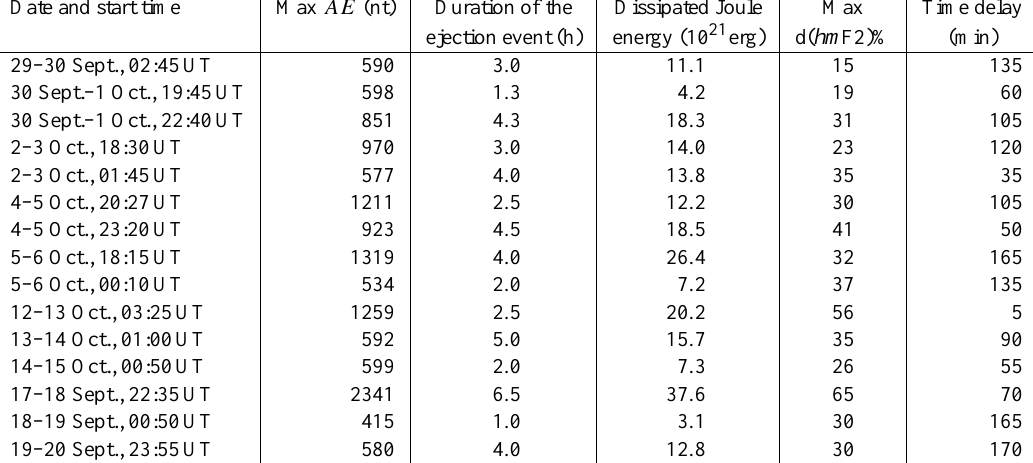
Fig. 9. The development of AL , AU and AE indices is compared with the d( hm F2)% deviations individually for four events of nighttime uplifting of the F2-layer. The night hours between 18:00LT and 06:00LT are presented in this figure for the nights between 2–3 October (a) , 12–13 (b) and 13–14 (c) and 17–18 September (d) . The events of height enhancements and the AE peak that caused them are marked with the grey colour. Table 1. Summary of the auroral oval energy injection events in conjunction with the ionospheric height enhancements at middle latitudes Date and start